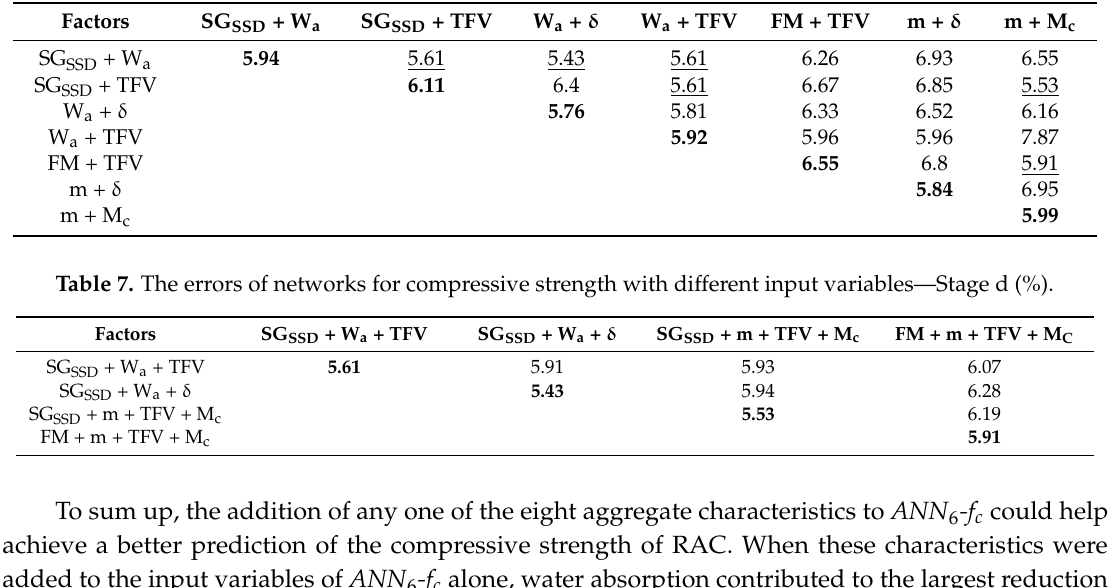
Table 6. The errors of networks for compressive strength with different input variables—Stage c (%).